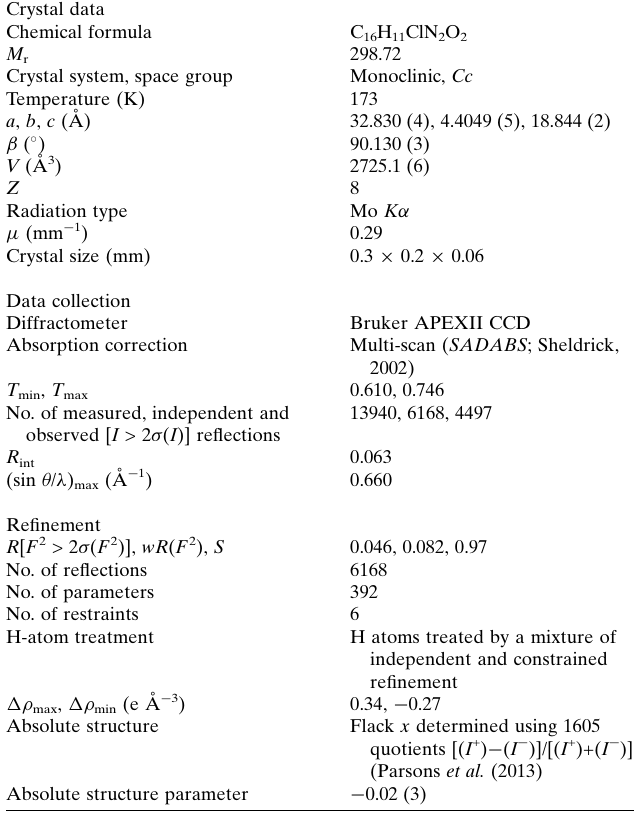
Table 3 Experimental